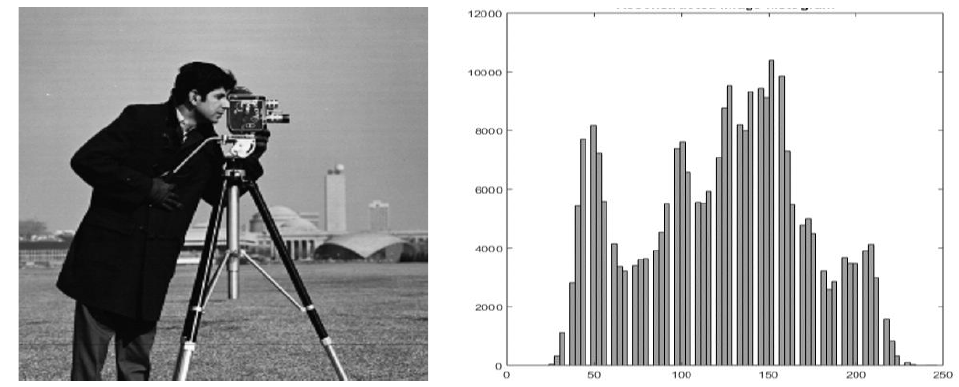
Figure 2. Cameraman and its histogram